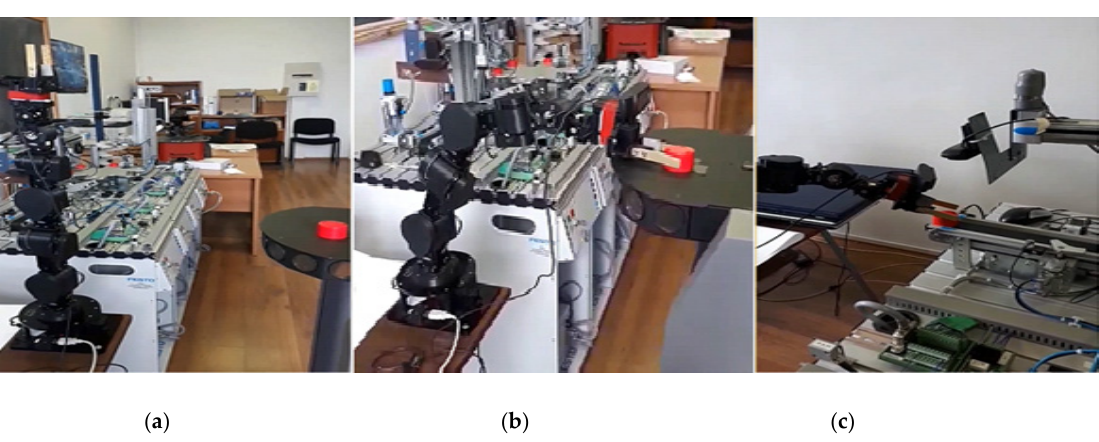
Figure 19. ( a ) X-axis and ( b ) Y-axis motion tracking errors for ARS PeopleBot, in absolute coordinates.